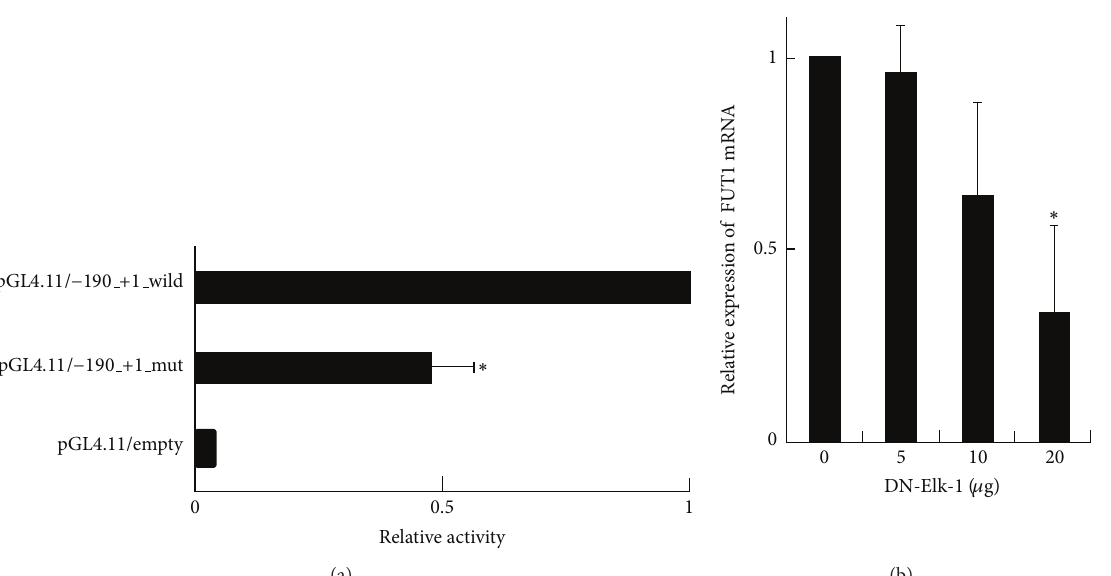
Figure 3: Site-directed mutagenesis on FUT1 promoter and effect of DN-Elk-1 overexpression on expression of FUT1 mRNA in DLD-1 cells. (a) Mutagenesis in the region − 90 to − 81 of the FUT1 promoter. 10 𝜇 g of the wild (pGL4.11/ − 190 +1 wild) and mutant (pGL4.11/ − 190 +1 mut) constructs and 0.5 𝜇 g of pRL-CMV were co-transfected into DLD-1 cells and luciferase activity was determined 24h aftertransfection. In each case, firefly luciferase activity was normalized to Renilla luciferase activity to correct for differences in transfection efficiency. The relative activities of luciferase are normalized to the activities of pGL4.11/ − 190 +1 wild as 100. The results obtained in three independent experiments are expressed as mean ± SD. Significant differences ( 𝑃 < 0.05 ) compared with the equivalent wild-type reporter construct are indicated by asterisks. (b) FUT1 mRNA expression in DN-Elk-1-transfected cells. After transfection with 5, 10, and 20 𝜇 g DN-Elk-1 expression vector, FUT1 mRNA expression levels in DLD-1 cells were determined by RT-PCR. The results were obtained in three independent experiments and data represent mean ± SD. Significant differences ( 𝑃 < 0.05 ) compared with non-transfected cells are indicated by asterisks.